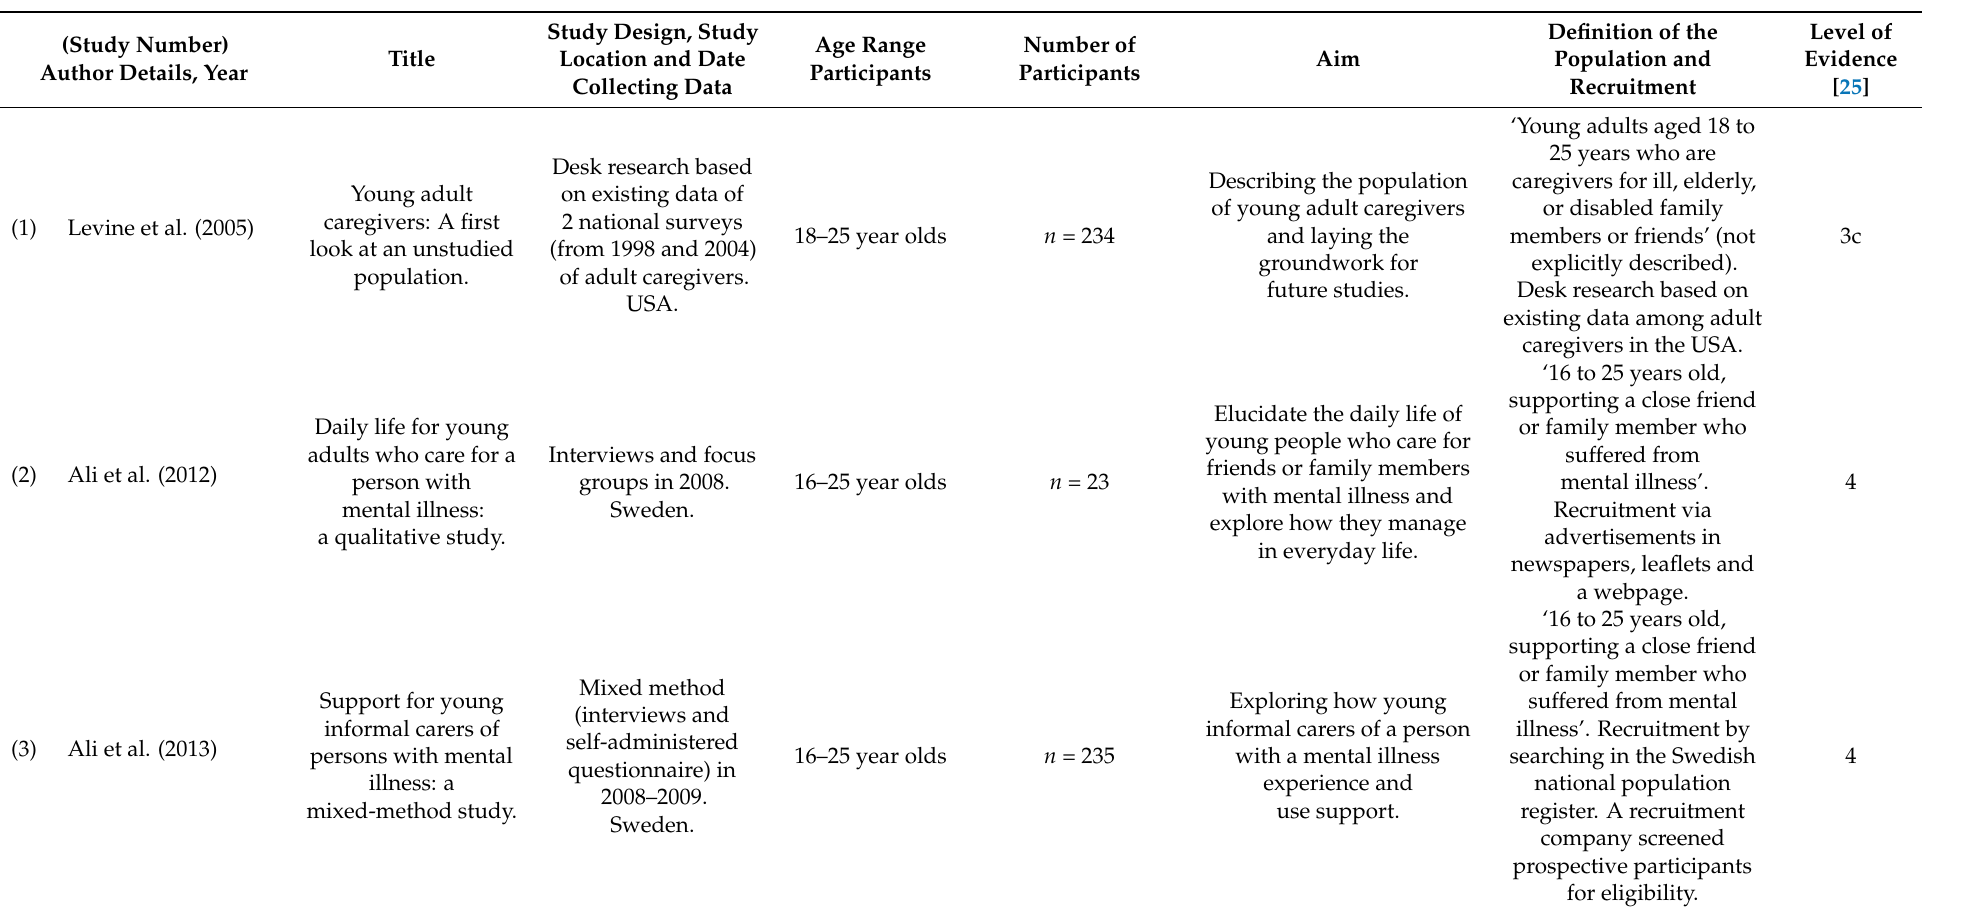
Table 1. Matrix scoping